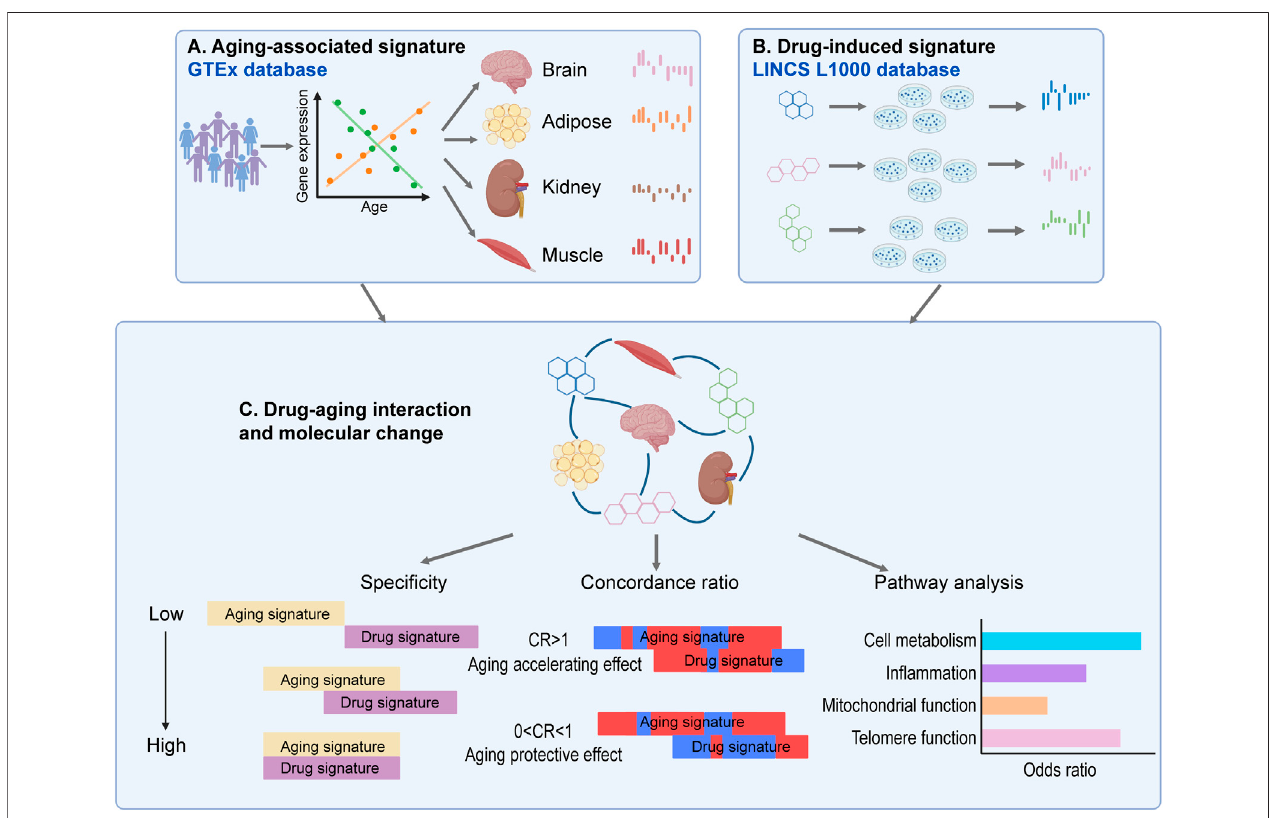
FIGURE 1 | The computational framework to characterize the cancer drug-aging interaction. (A) Identi fi cation of aging-associated expression signatures in different tissue types in GTEx database. (B) Identi fi cation of drug-induced expression signatures in different normal cells from LINCS L1000 database. (C) Interaction of drug-induced signature and aging-associated signature characterized by speci fi city, adjusted concordance ratio and enriched functional pathways.